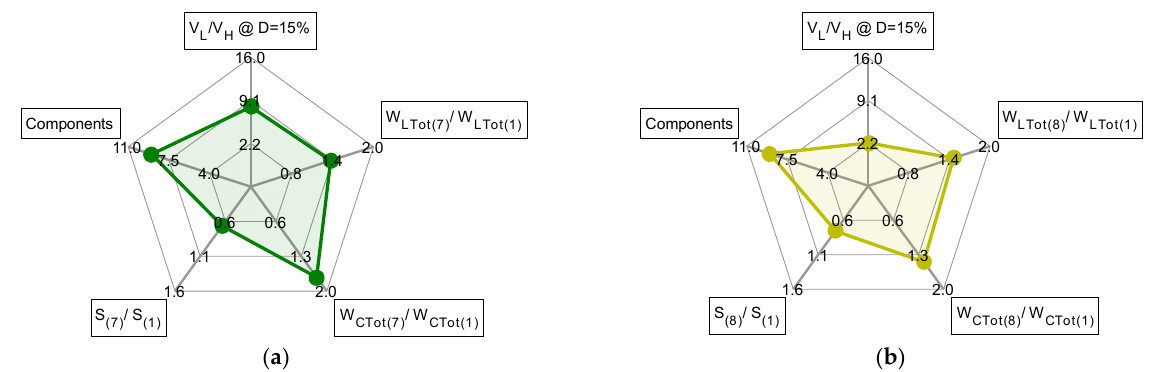
Figure 12. Radar chart with 5 axes: voltage conversion ratio (@D = 15%); number of components; total active switch stress; mean inductor energy; mean capacitor energy. ( a ) Chart of converter 5. ( b ) Chart of converter 6.